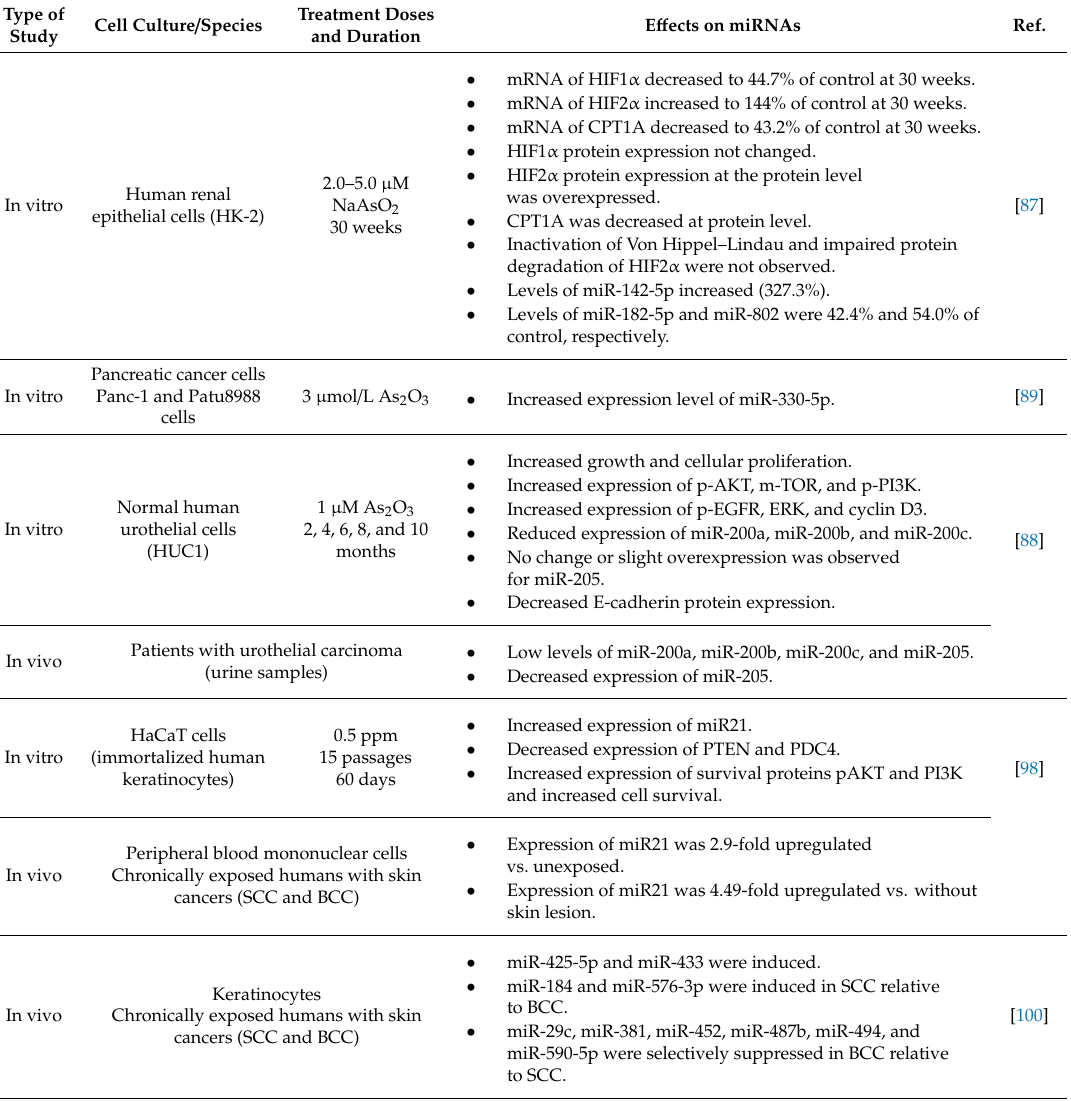
Table 2. Summary of studies analyzing e ff ects of As on